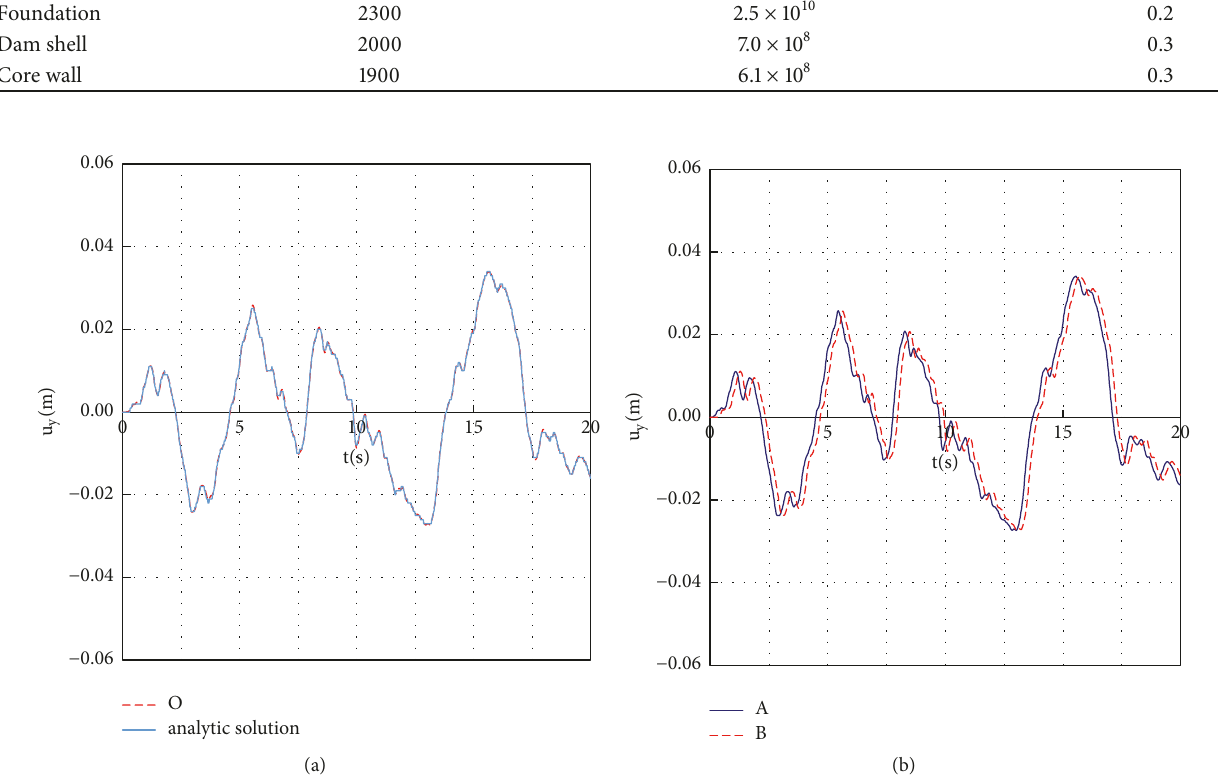
Figure 13: Vertical displacement histories of typical points: (a) point O and (b) points A and B.